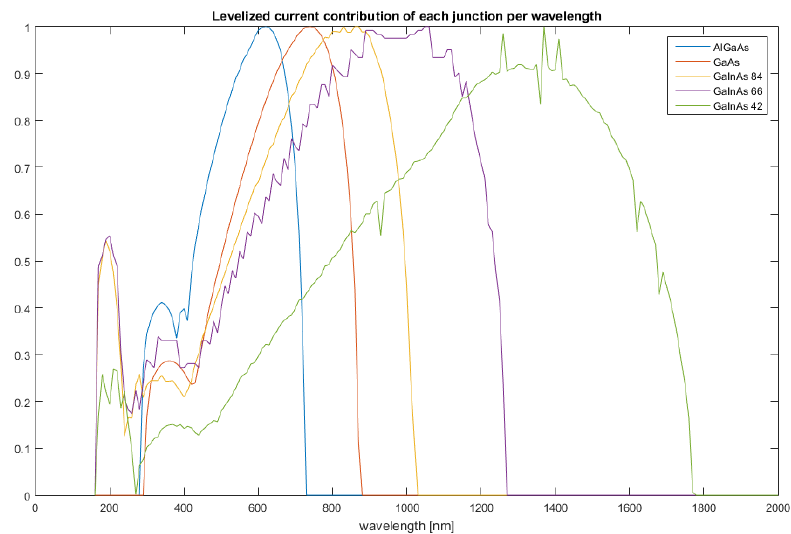
Figure 10. Layer current contribution as a function of wavelength.